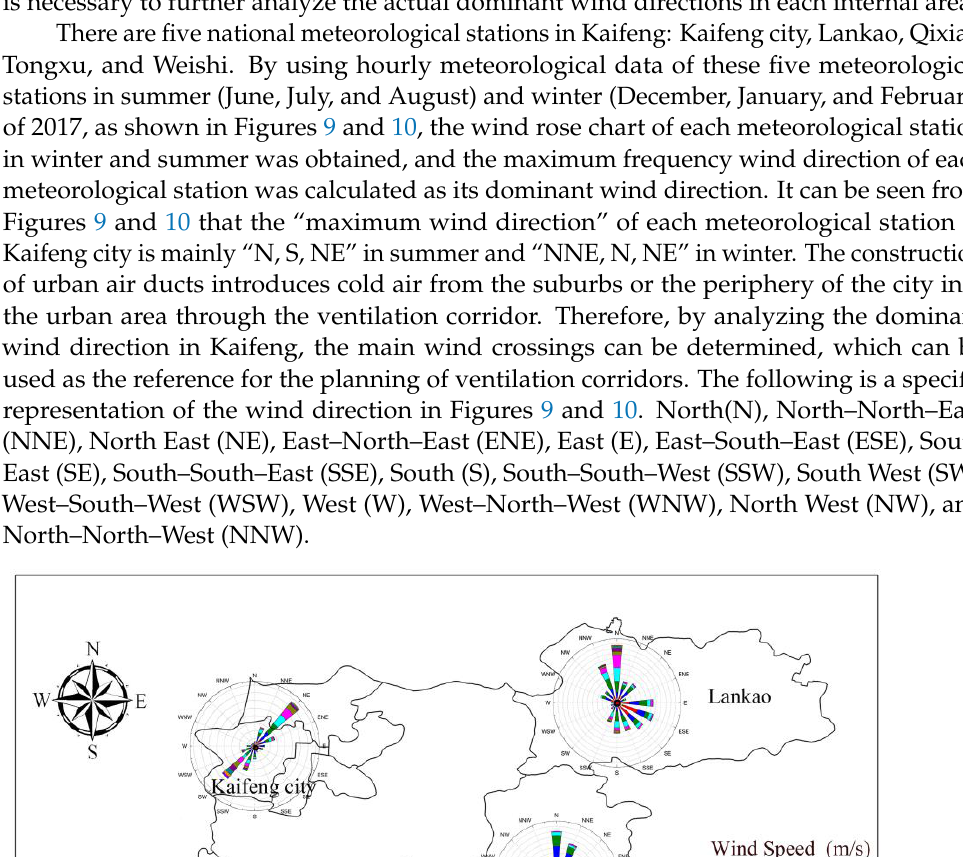
Figure 10. The dominant wind direction in winter (December, January, and February). According to the dominant wind direction in Kaifeng, it is shown that the air flow from the Yellow River and the outer suburbs can blow into the city and help reduce the temperature inside the city and possibly alleviate the urban heat island effect. Therefore, on the basis of analyzing the land surface temperature, action space, underlying surface influential factors, and dominant wind direction in Kaifeng, air duct openings were se- lected in the Yellow River, Kaifeng Yintan, Baogong Lake, and Longting Lake, and under the action of the dominant wind direction, airflow can blow into the city through the Yel- low River – Kaifeng Yintan, Yellow River – Longting Lake – Baogong Lake and other water bodies.